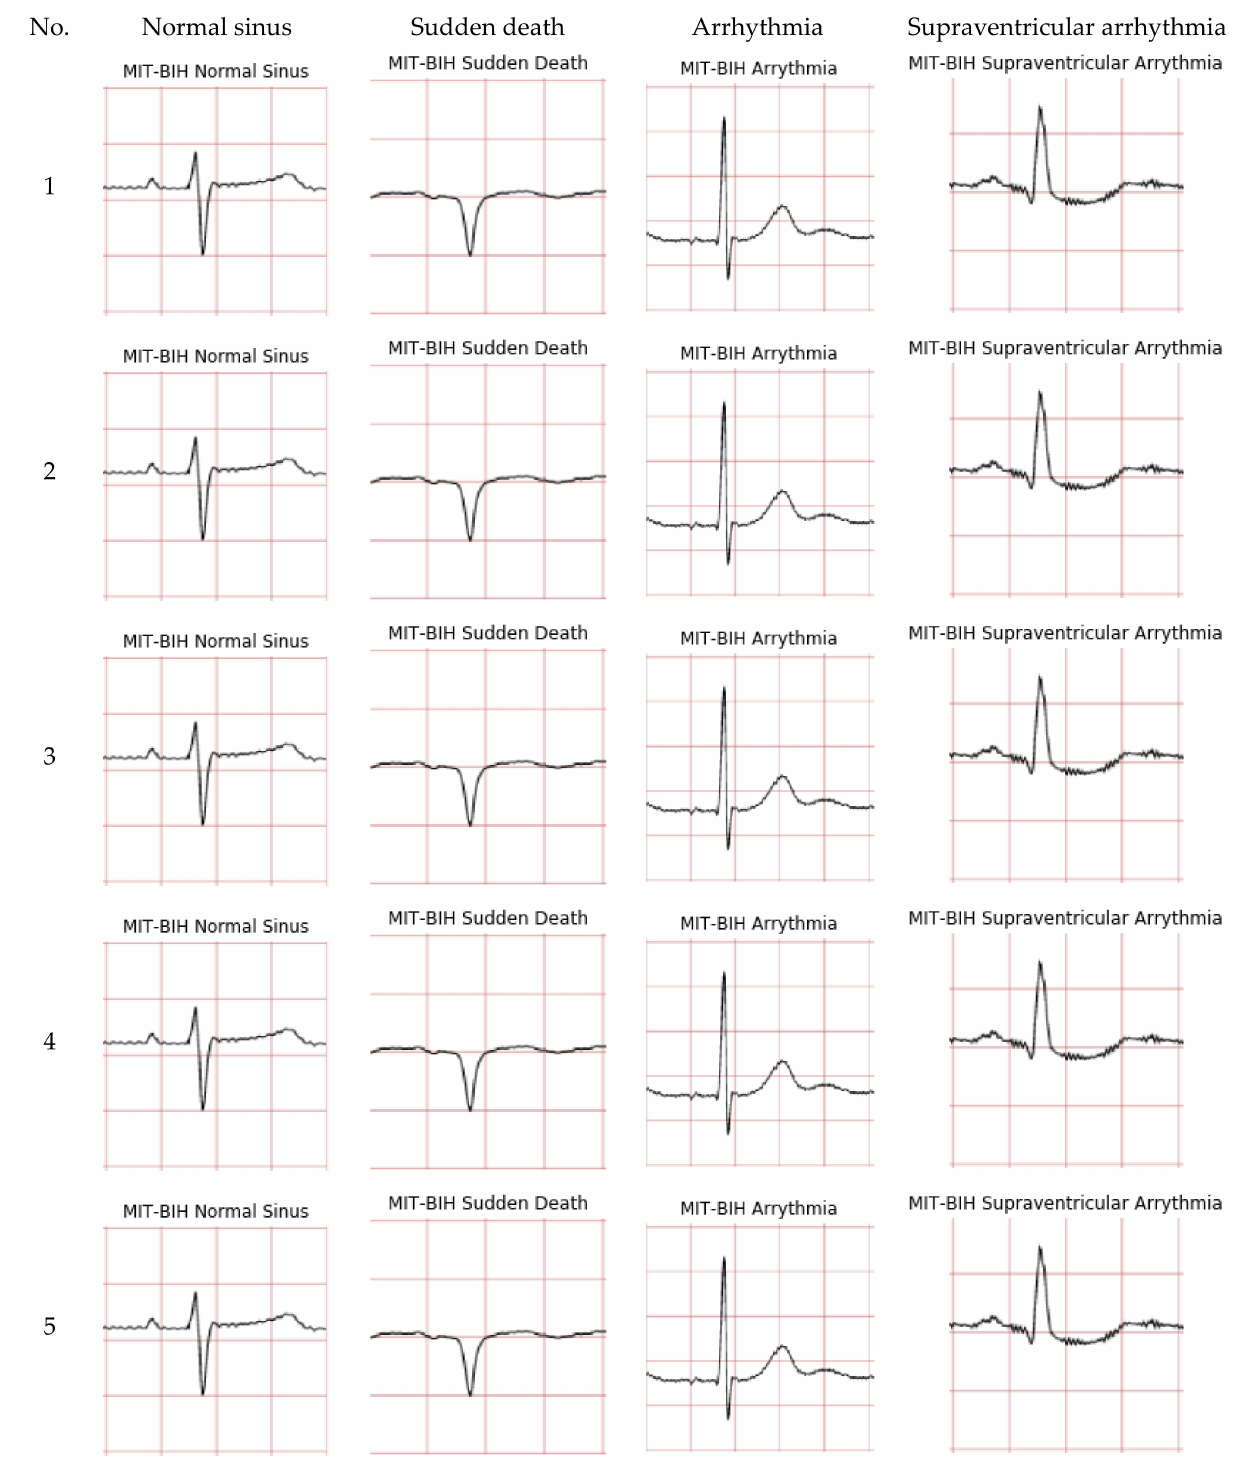
Figure 5. Preprocessed of ECG images for CNN data